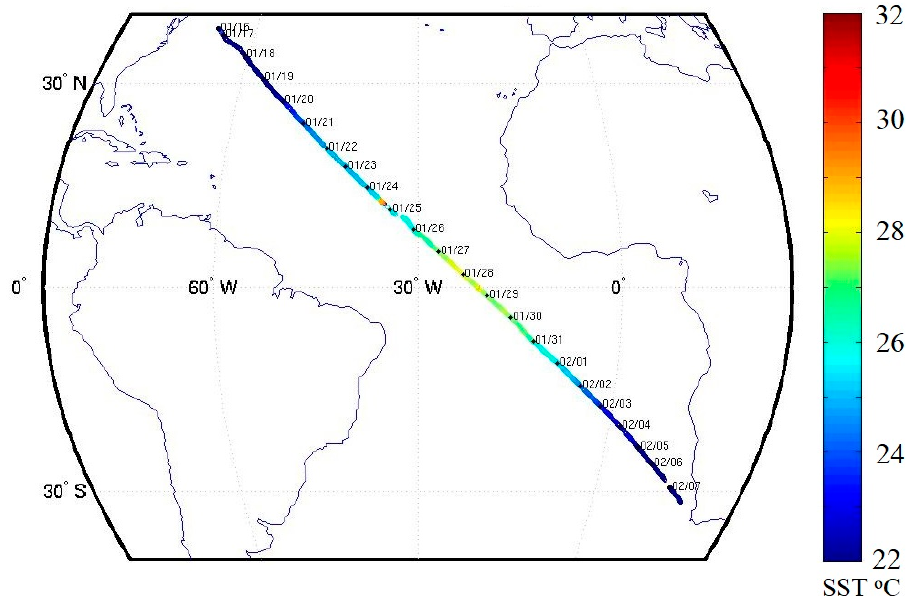
Figure 5. Ship track of the R/V Knorr from Woods Hole to Cape Town. The colors indicate SST skin derived from Marine-Atmospheric Emitted Radiance Interferometer (M-AERI) measurements, in °C according to the color bar at right. The dates (mm/dd) show the positions of the ship at the start of each UTC (Coordinated Universal Time) day.